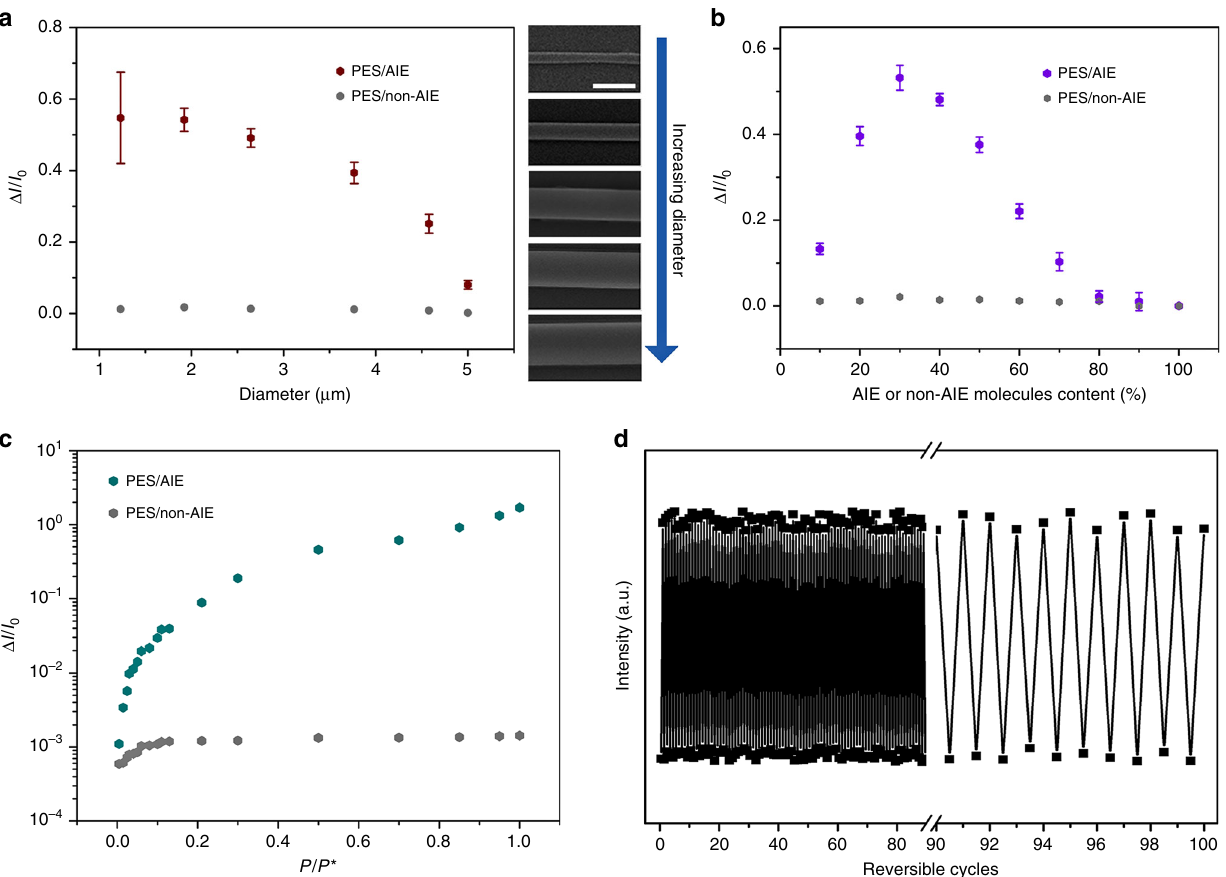
Fig. 3 Sensor response characteristics of polymer/AIE molecule microwires. a The diameter dependence of the relative variations of the fl uorescent intensity, Δ I / I 0 (where I 0 is de fi ned as the baseline fl uorescent intensity of the PES/AnPh 3 microwires prior to exposure to acetone vapor, and Δ I represents the fl uorescent intensity change of these microwires after and before exposure to acetone vapor), shows downward trend with the increase of diameter of the PES/AIE microwires, but shows almost constant in the case of PES/non-AIE microwires. The used polymer is PES, the AIE molecule is AnPh 3 , and the non-AIE molecule is Ph 3 A 2 . Insets are SEM images of PES/AnPh 3 microwires with different diameters, all scale bars are 5 μ m. Error bars, s. d. ( n = 50). b The curve illustrates the dependence of Δ I / I 0 on the AIE molecules content or the non-AIE molecules content, which indicates the trend of increasing at fi rst and then decreasing with the increase of AnPh 3 content of the microwires, but keeps almost constant with the increase of Ph 3 A 2 content. Error bars, s.d. ( n = 50). c Δ I / I 0 for the PES/AnPh 3 microwires or PES/Ph 3 A 2 microwires in response to varying partial pressures, P , of acetone vapor. P * is the vapor pressure of acetone under ambient conditions. The result indicates that, in the case of PES/AnPh 3 microwires, Δ I / I 0 enhances during